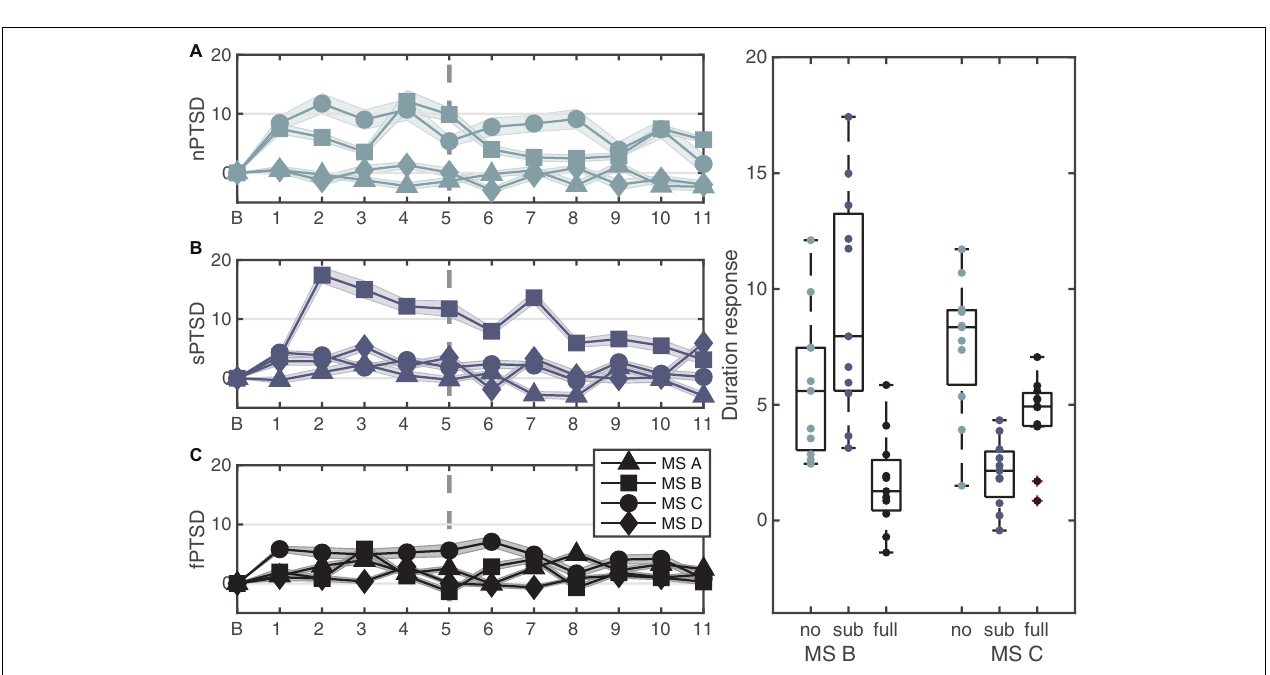
FIGURE 7 | Time series of the LKM-S showing the duration response from baseline B of each microstate for each group nPTSD (A) , sPTSD (B) , and fPTSD (C) . The line at minute 6 indicates the shift in focus from others (1–5) to self (6–11). Panel (D) shows significant differences in duration response over the whole LKM-S between groups for microstates MS B and MS C; * p < 0.05, ** p < 0.01, **** p < 0.0001.